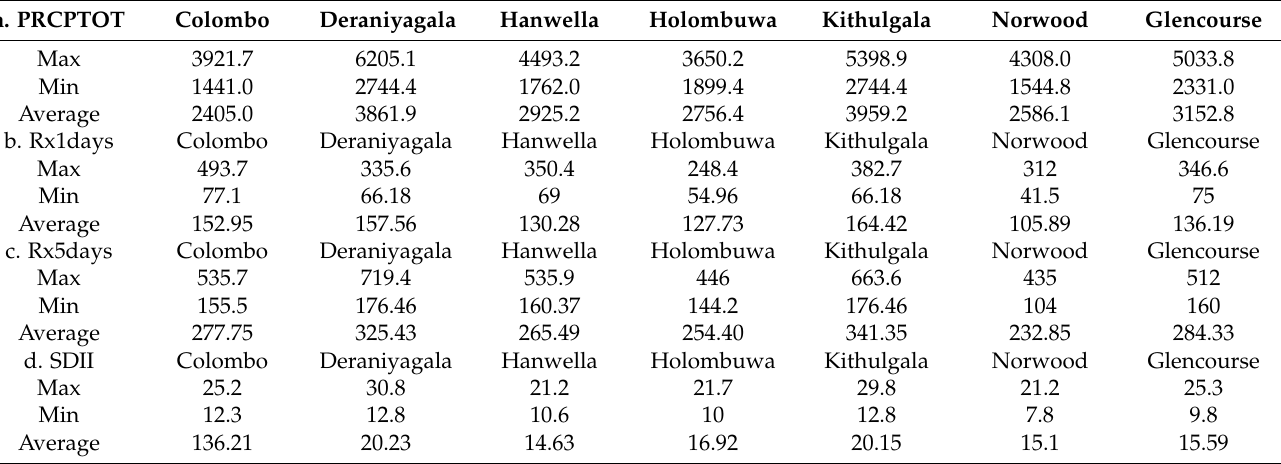
Table 4. Maximum, minimum, and average PRCPTOT (mm), Rx1days, Rx5days, and SDII in the study area from 1961 to